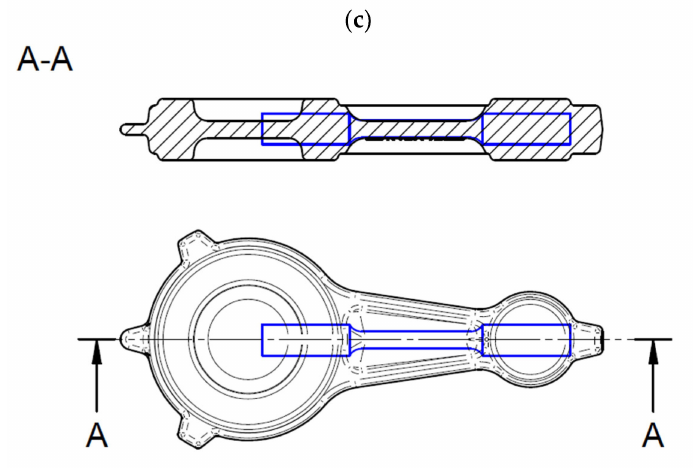
Figure 15. Sampling locations for mechanical properties testing marked with a blue line: ( a ) variant 1 preform; ( b ) variant 2 preform; ( c ) forging.